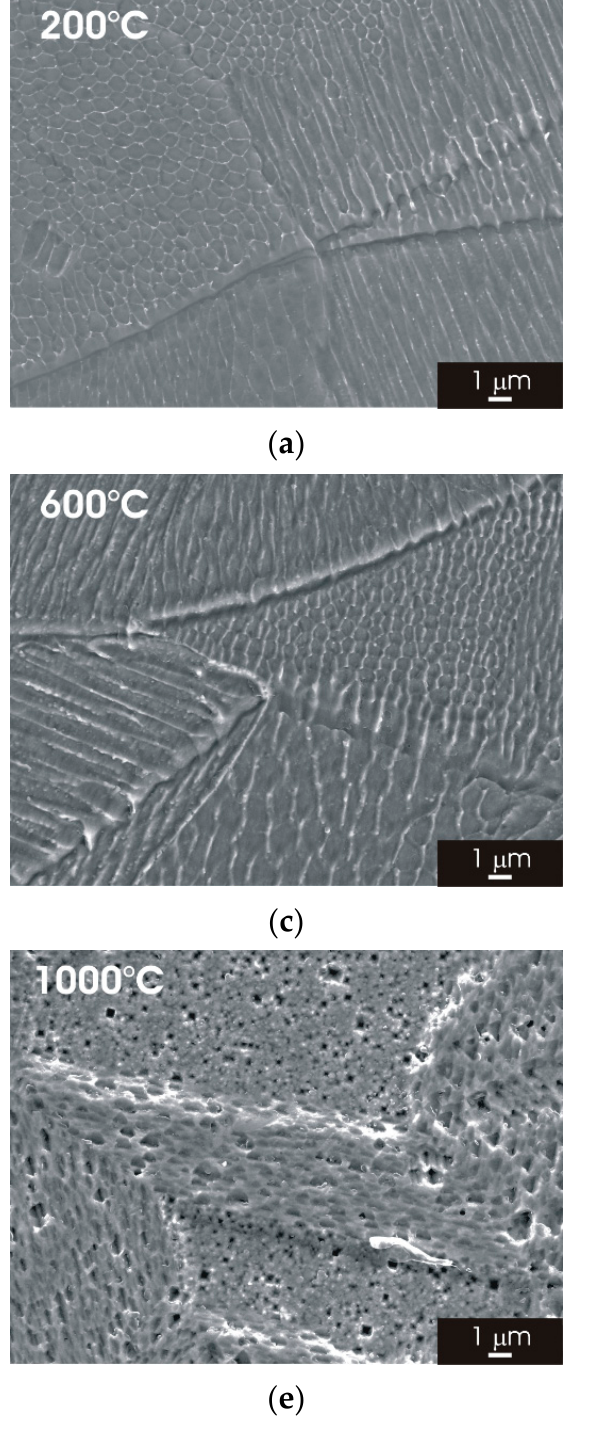
Figure 4. SEM micrographs of L-PBF-XY 316L stainless steel after 2 h thermal treatment. ( a ) 200 °C; ( b ) 400 °C; ( c ) 600 °C; ( d ) 800 °C; ( e ) 1000 °C; ( f ) 1100 °C